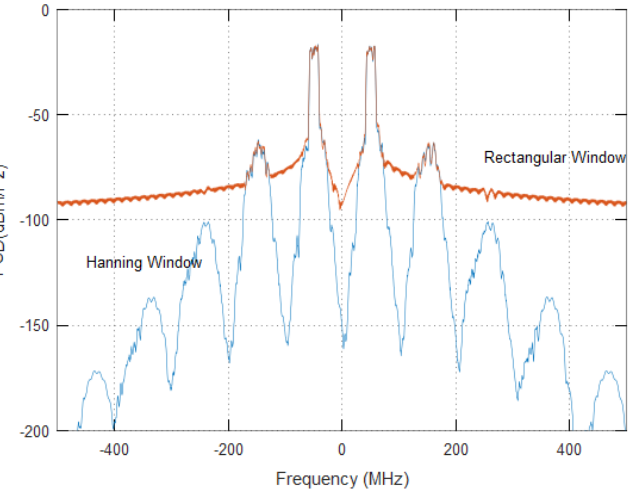
Figure 5. PSD of the output of the passive nonlinearity using a Hanning window and a rectangular window.